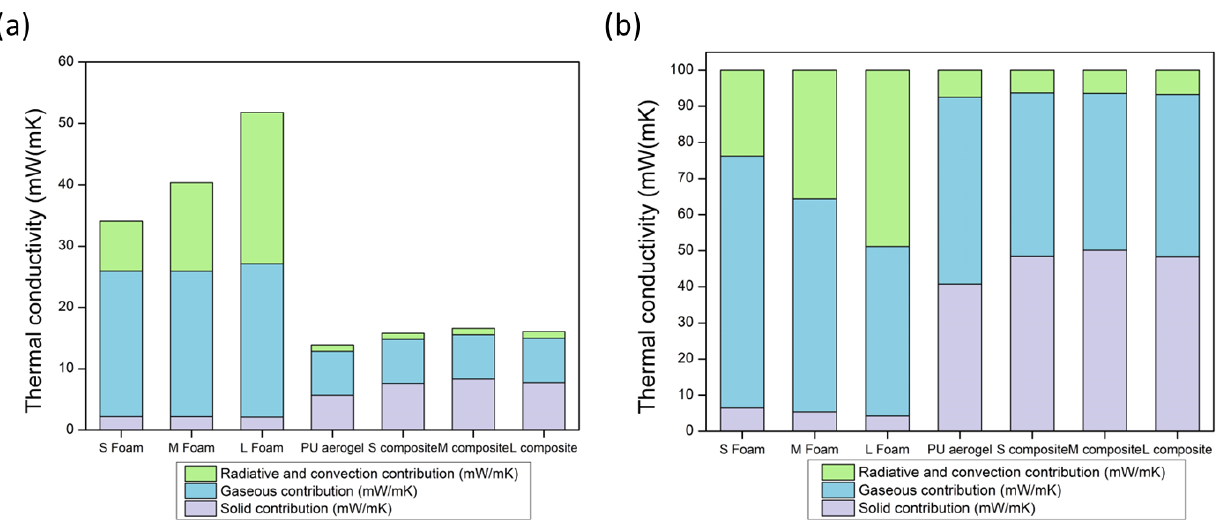
Figure 11. ( a ) Thermal conductivity contributions for the PU foams, PU aerogel, and composites, ( b ) percentage of the thermal conductivity contributions for the PU foams, PU aerogel, and composites.